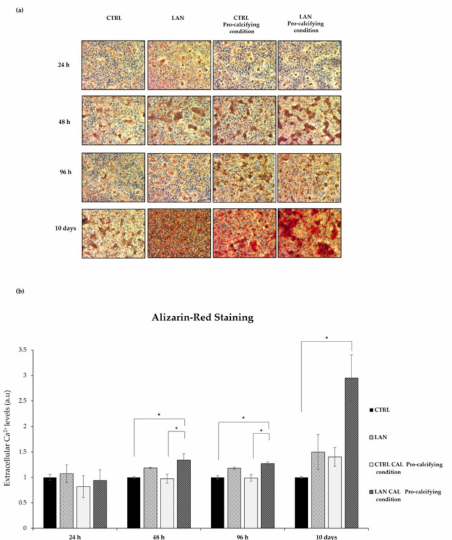
Figure 6. Lanthionine’s effects on calcium deposition in EA.hy926 cell cultures and medium incubated in pro-calcifying conditions. The Alizarin Red S staining and extracellular calcium content assay after 1 µ M of lanthionine and 1 µ M of lanthionine with 2.8 mM of CaCl 2 and 3 mM of NaH 2 PO 4 treatment at 24 h, 48 h, 96 h and 10 days. To understand the effects of lanthionine in a pro-calcifying condition, a control with 2.8 mM of CaCl 2 and 3 mM of NaH2PO 4 was used. ( a ) The images were observed by a LEICA DM-IRB microscopy equipped with a 5 × objective Optika camera software; ( b ) the extracellular calcium levels were quantified using cetylpyridinium chloride at 562 nm (see “Section 2”) and normalized to protein content. The columns represent the mean and error bars indicating the SD from three independent experiments. The untreated control is shown as a bar made equal to 1. p -values versus untreated control = * p < 0.05, (according to Anova-test). CTRL, untreated control; LAN, lanthionine; CTRL Pro-calcifying condition, with 2.8 mM of CaCl 2 and 3 mM of NaH 2 PO 4 ; LAN Pro-calcifying condition, lanthionine with 2.8 mM of CaCl 2 and 3 mM of NaH 2 PO 4